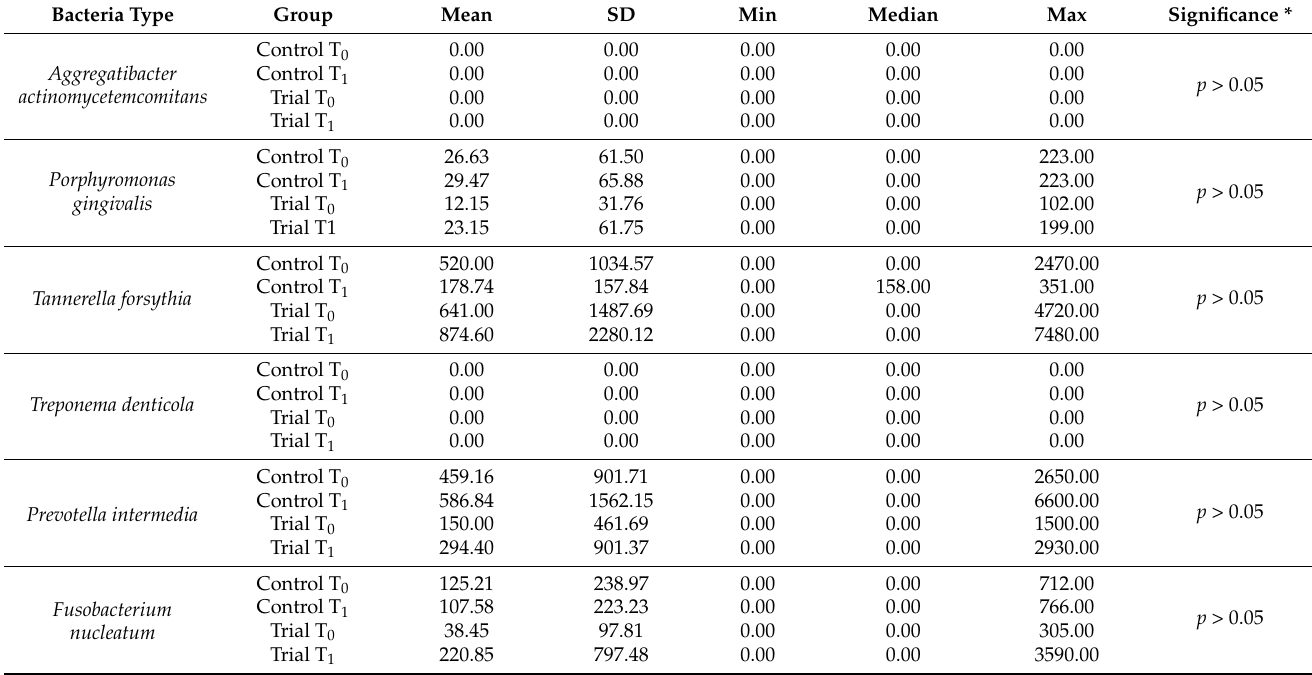
Table 4. Descriptive statistics of each bacterial count expressed as copies/microlitre.